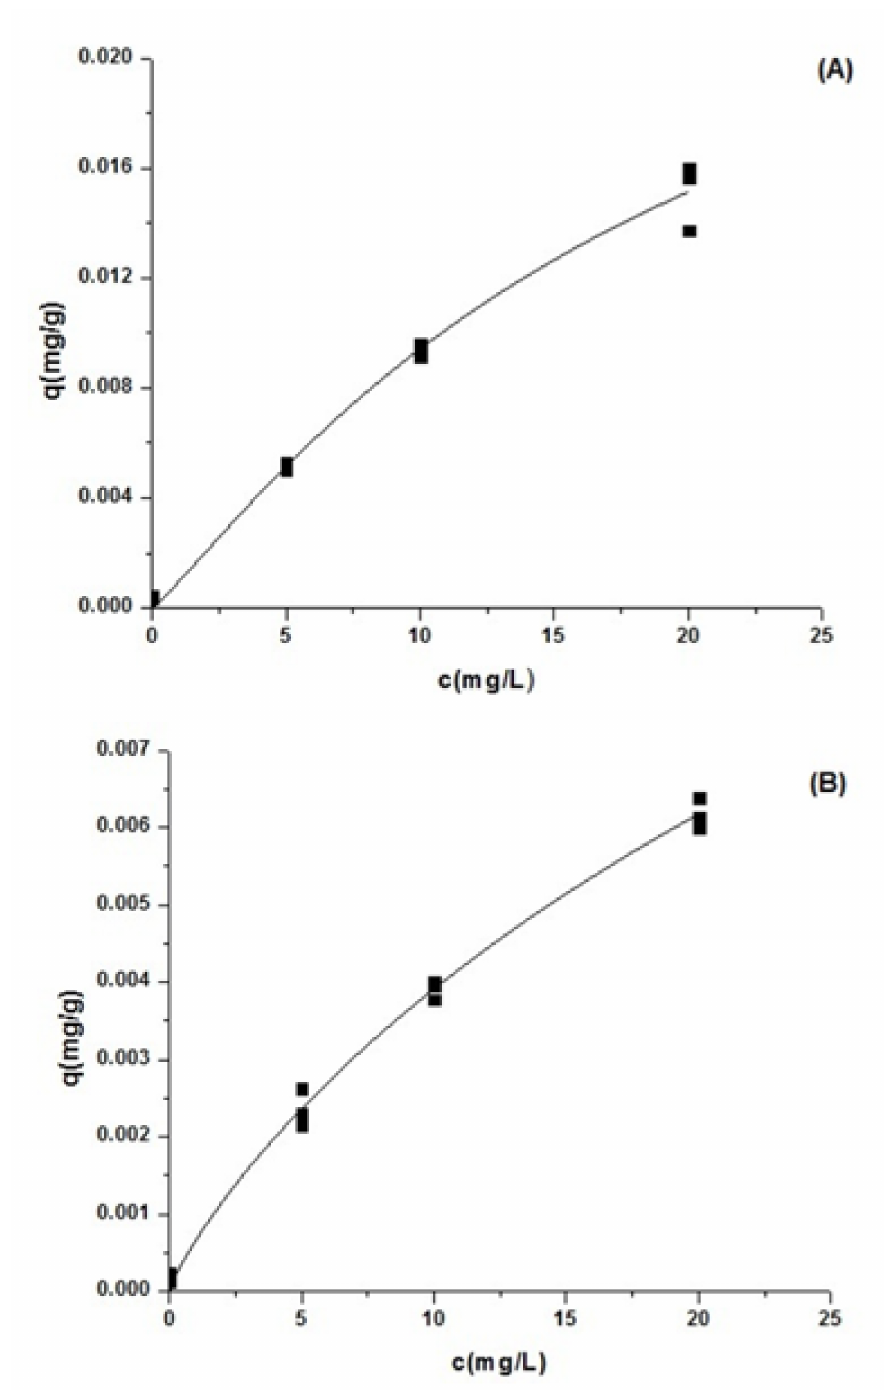
Figure 2. Equilibrium results of the adsorption of Zn 2+ . ( A ) Tetraselmis marina AC16-MESO liv- ing biomass; ( B ) Tetraselmis marina AC16-MESO non-living biomass. Experimental data on the equilibrium adsorbed concentration of Zn 2+ (q, mg · g − 1 ) versus the equilibrium Zn 2+ concentra- tion in the liquid phase (C, mg · L − 1 ) represented together and fit into the Langmuir equilibrium isotherm